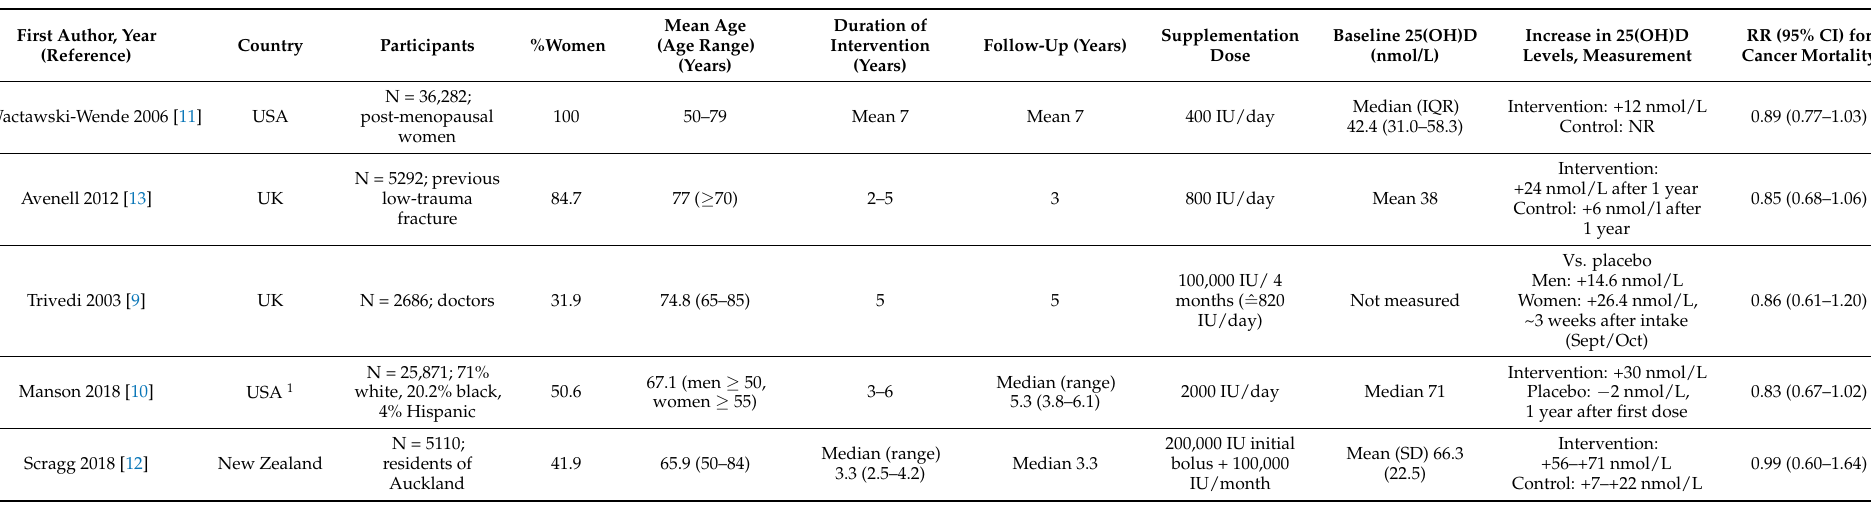
Table 2. Characteristics of the 5 studies included in the meta-analysis of vitamin D supplementation and cancer mortality from Keum et al. [1], sorted by daily